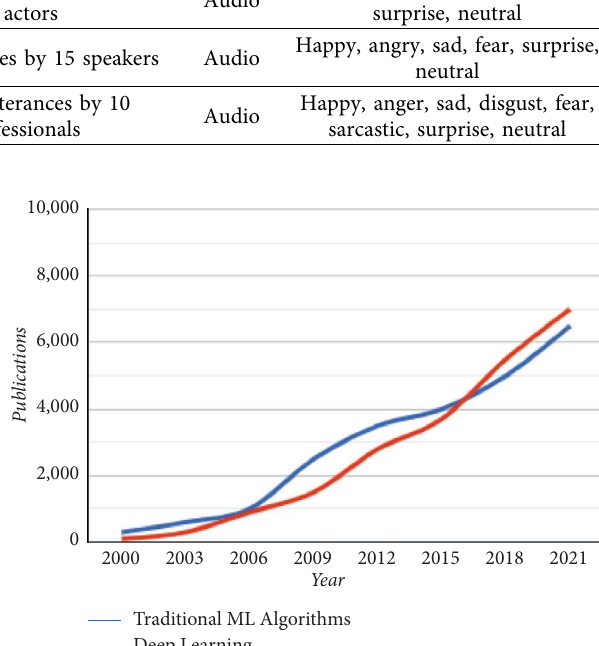
Figure 2: Growth of using deep learning techniques for SER. Te graph displays the publication number in the last two decades, having machine learning or deep learning terms in the title of SER papers, according to Google Scholar around the time this article was